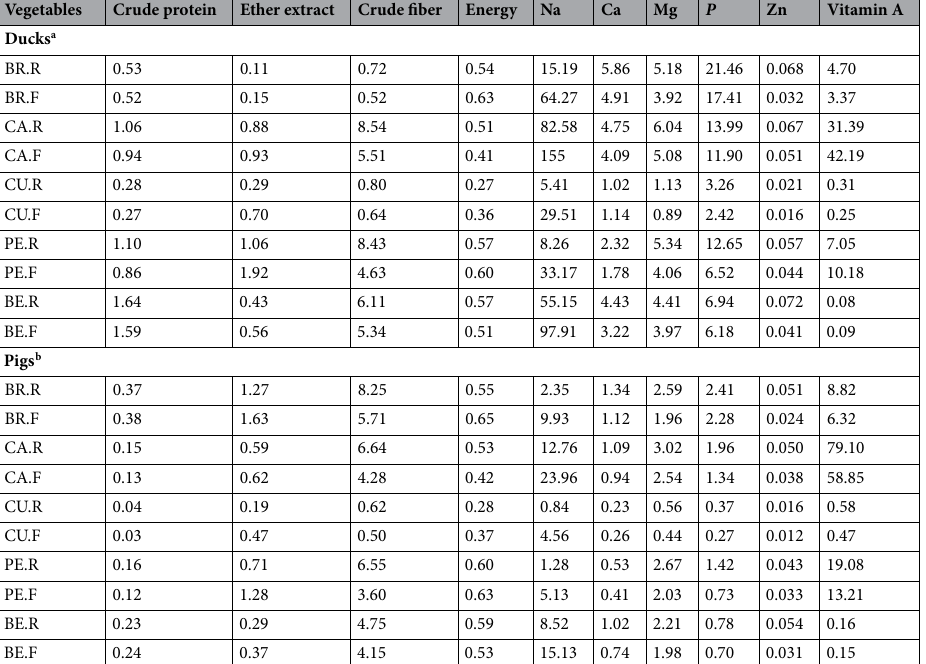
Table 9. Percent coverage of daily demand for selected nutrients, minerals, and vitamin A by raw and fermented vegetables (100 g dry matter) consumed by monogastric animals (ducks and pigs). a Coverage for broiler ducks in rearing period III (finisher) in 1 kg of feed 19 . b Coverage for fatteners in rearing period III (finisher) in 1 kg of feed 20